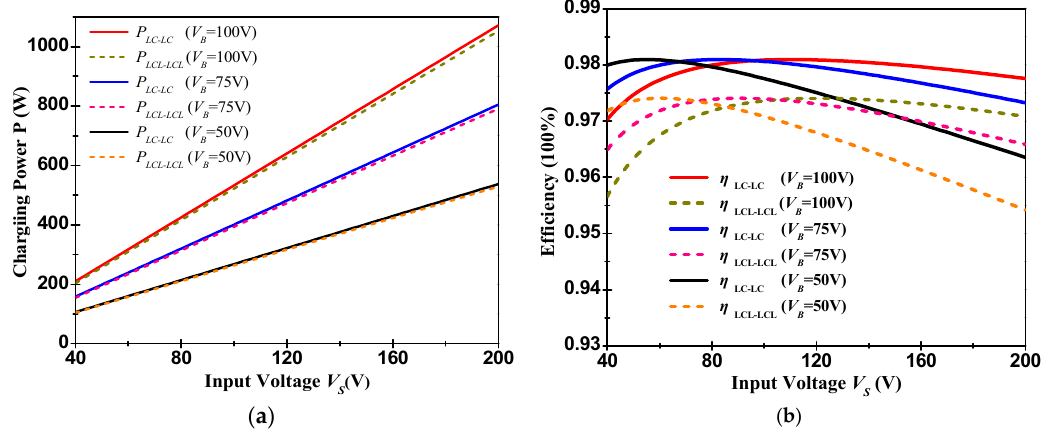
Figure 3. Cont. Figure 3. Theoretical transfer power ( a ) and efficiencies ( b ) of the LC ‐ LC series and LCL ‐ LCL topologies. Figure 3. Theoretical transfer power ( a ) and efficiencies ( b ) of the LC-LC series and LCL-LCL